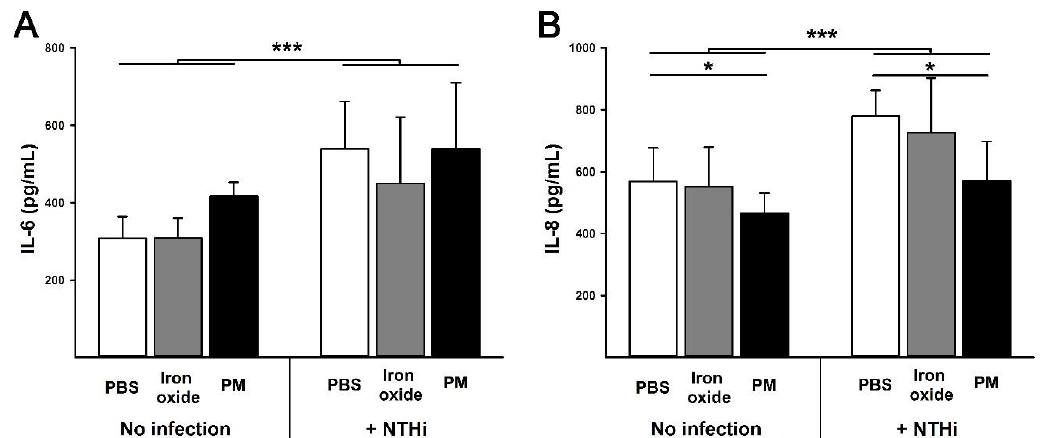
Figure 2. Cell viability of bronchial epithelial cells (NuLi-1) with (left) or without (right) three hours of exposure to 10:1 MOI of non-typeable Haemophilus influenzae (86-028NP strain; NTHi)). Prior to bacterial exposure, cells were exposed to either media alone (white bars), 10 µg/mL of iron oxide particles in media (grey bars) or 10 µg/mL of community sampled PM 10 in media (black bars) for 24 h. Data are presented as mean (SD). * indicates p < 0.05. Cell viability was reduced by NTHi exposure but was not altered by particle exposure.